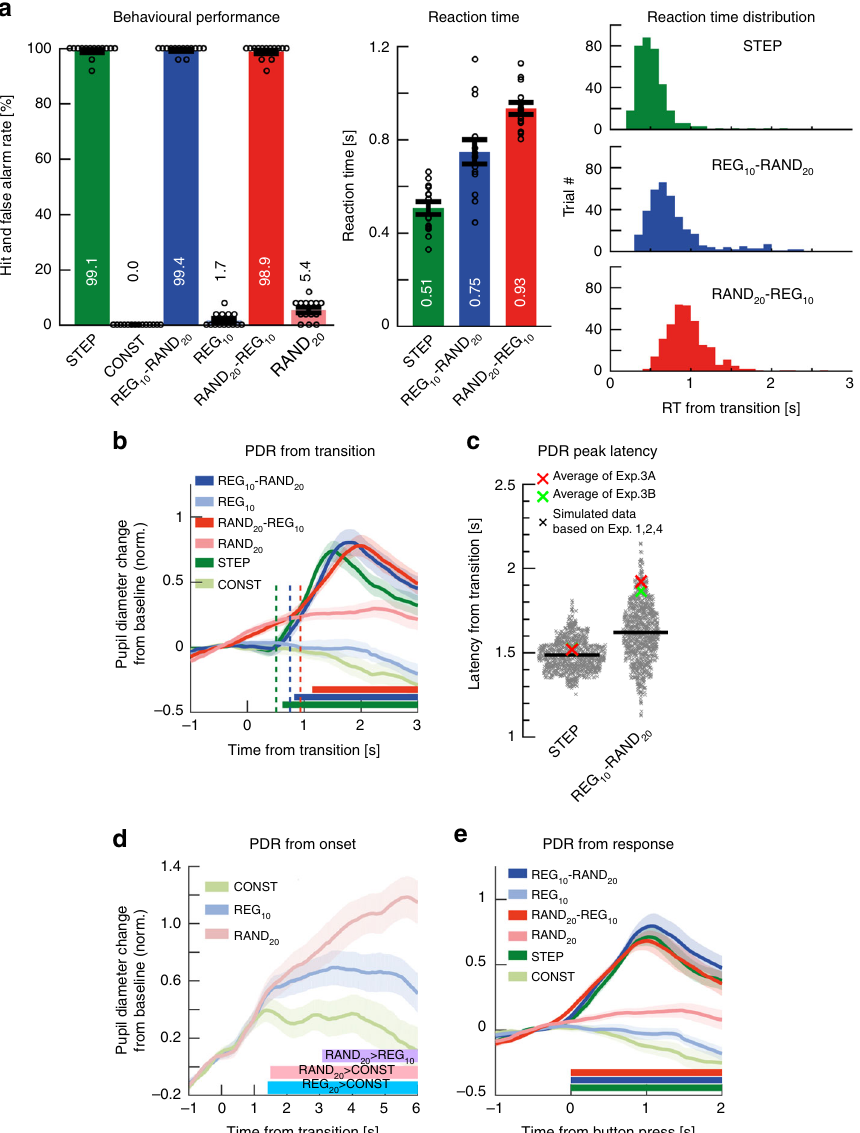
Fig. 6 Experiment 3A ( n = 14): Active transition detection. a Behavioral performance (transition detection). [Left] Hit rates and false positive rates. Circles indicate individual subject data; error bars are ±1 SEM. [Middle] Reaction times (RT). [Right] The distribution of RTs (across trials and participants) for each transition condition. The variance of the RT distribution of RAND 20 -REG 10 was smaller than that of REG 10 -RAND 20 (Levene ’ s test, F (1,690) = 14.426, p = 0.0002). b Average pupil diameter relative to the transition. Solid lines represent the average normalized pupil diameter, relative to the transition. Shading shows ±1 SEM. Colored horizontal lines indicate time intervals where cluster-level statistics showed signi fi cant differences between each change condition and its control. Dashed vertical lines mark the average RT for each condition. Clear PDRs were observed for all three transitions. The PDR to STEP increased from ~490 ms post-transition, peaking at 1500 ms; it statistically diverged from CONST from 620 ms through to sequence offset. For REG 10 - RAND 20 , the responses commenced ~750 ms post-transition, peaking at 1800ms, and statistically diverged from REG at 820 ms post-transition through to sequence offset. For RAND 20 -REG 10 , the response started at 930 ms, peaked at 1980ms, and statistically diverged from its control RAND 20 from 1140 ms onwards. c A comparison of PDR peak latency to STEP and REG 10 -RAND 20 in Experiment 3 relative to Experiments 1, 2, and 4 (see Methods). The scatterplots show the distribution of the simulated peak latency of STEP (left) and REG 10 -RAND 20 (right) in the gap detection experiments. The red and green crosses indicate the mean peak latency in Experiments 3A and 3B (see below), respectively. The results showed no difference for STEP (Exp 3A: mean = 1520 ms, p = 0.338, Expt3B: mean = 1521 ms, p = 0.341), but a greater latency for REG 10 -RAND 20 in Exp 3A (mean = 1921ms, p = 0.048, Exp 3B: mean = 1865ms, p = 0.090). d Average pupil diameter over time relative to the sequence onset. Colored lines indicate time intervals where cluster-level statistics showed signi fi cant differences between conditions. RAND 20 and REG 10 statistically diverged from CONST at 1500 and 1420 ms post-onset, respectively. Interestingly, RAND 20 evoked a larger tonic PDR than REG 10 from 3080 ms post-onset. e Average pupil diameter over time, relative to button